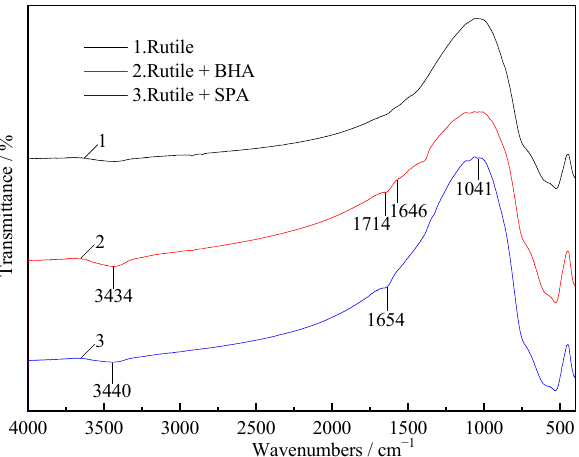
Figure 11. Effect of reagent combination on the hydrophobicity of rutile and garnet.